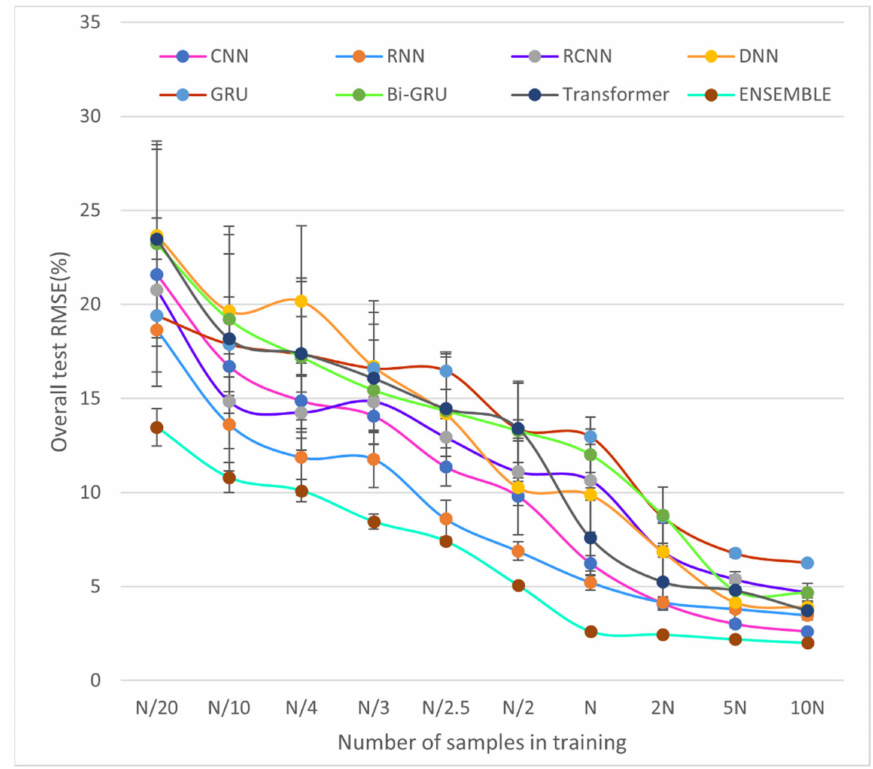
Figure 10. Comparison of model errors under different size training